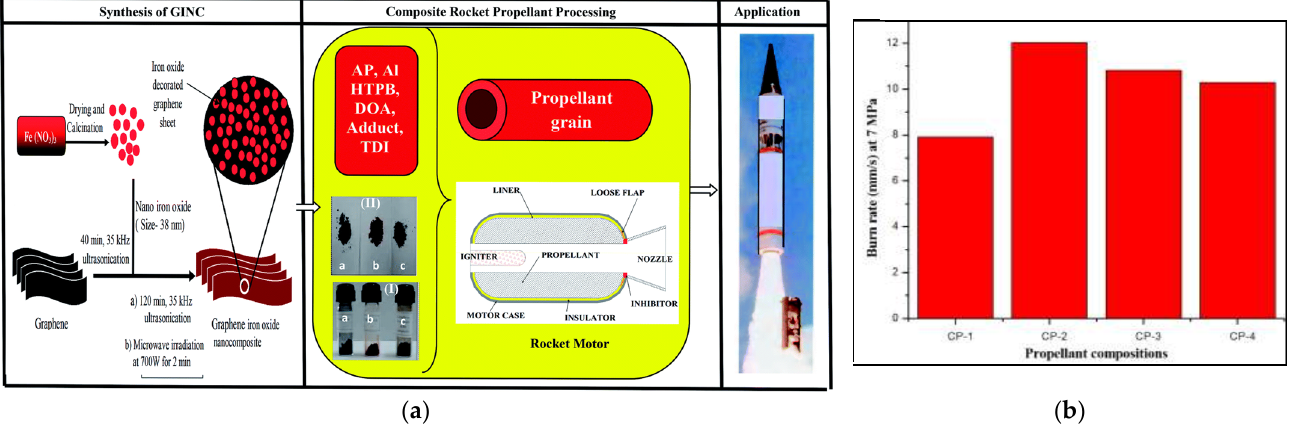
Figure 18. ( a ) Synthesis, processing and application of GINC as burn rate modifier in missile system; ( b ) burn rate of propellant. Reprinted from ref.